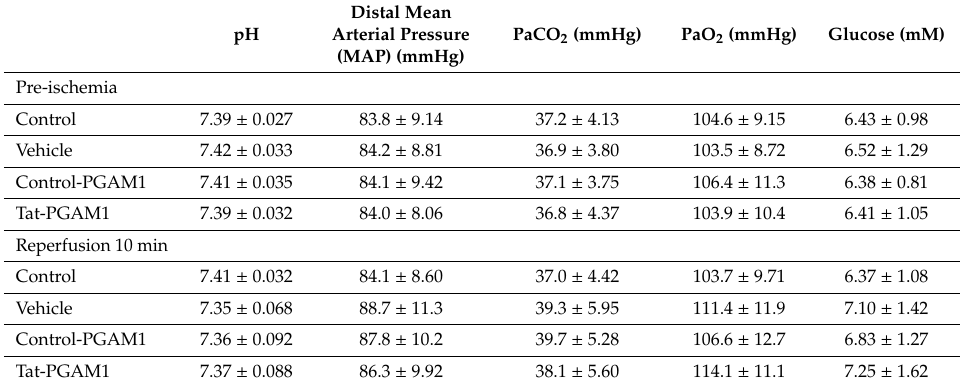
Table 1. The physiological parameters before and 10 min after spinal cord ischemia in rabbits.